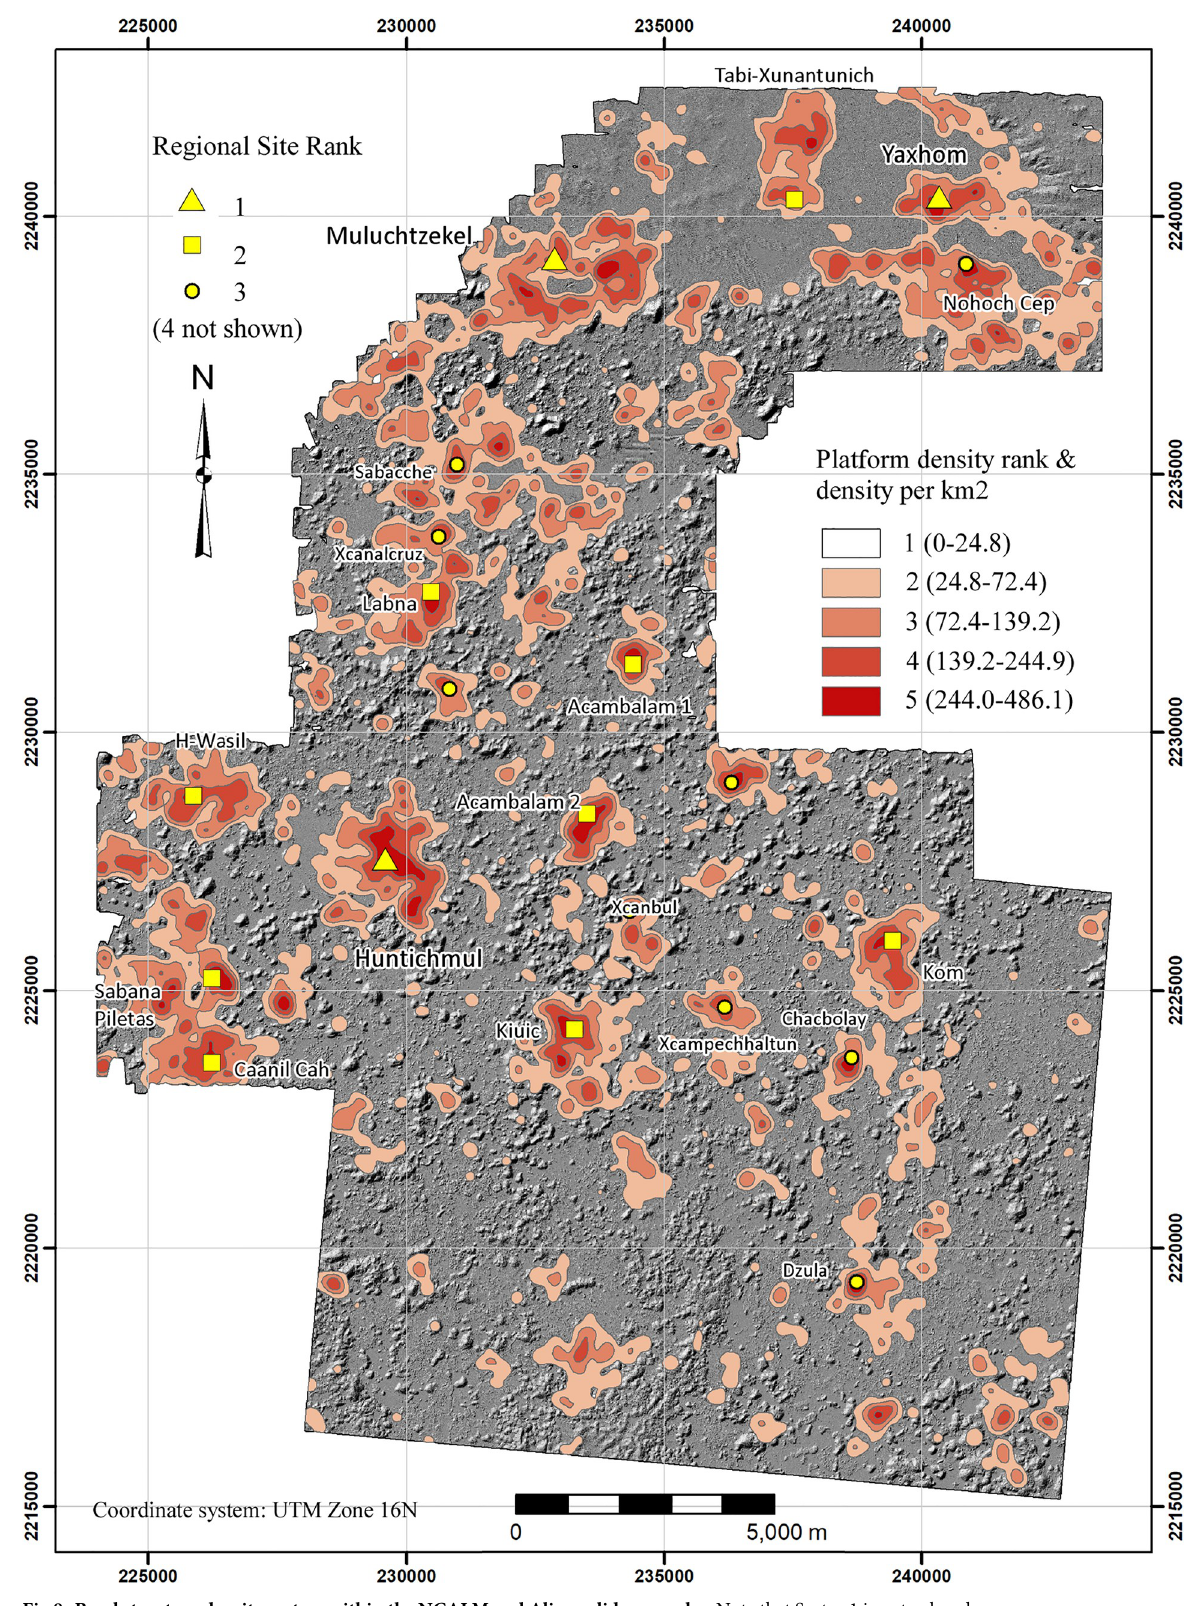
Fig 8. Basal structure density sectors within the NCALM and Alianza lidar samples. Note that Sector 1 is not colored.